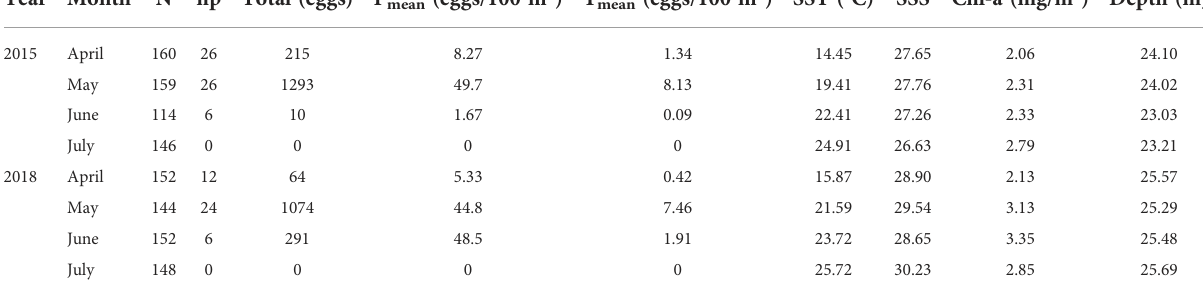
TABLE 1 Summary of variables of this study, including information on the surveyed stations, eggs, and hydrological variables, covering two distinct periods of 2015 and